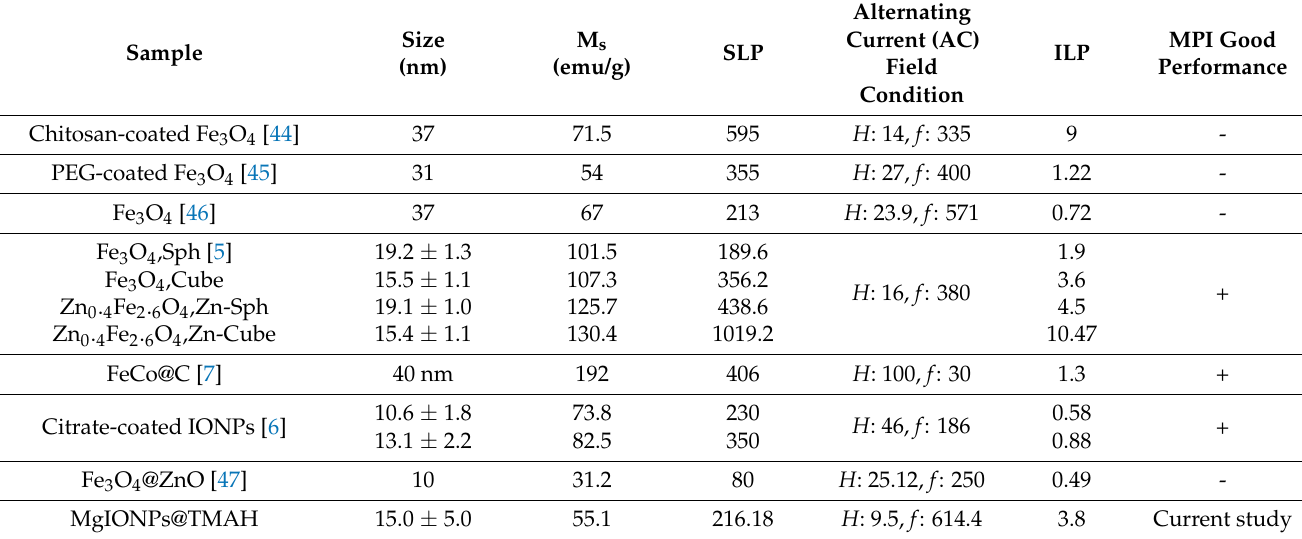
Table 2. Comparison between particles reported in the literature and the current